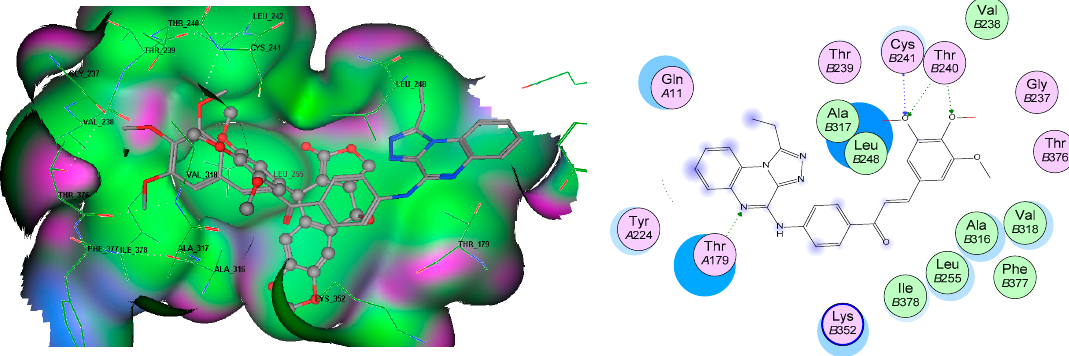
Figure 3. Molecular interactions graph of target compounds 7g in the tubulin pocket. Table 3. Docking scores, amino acid interactions and interacting groups of the docked compounds into the active site of EGFR-TK and tubulin.